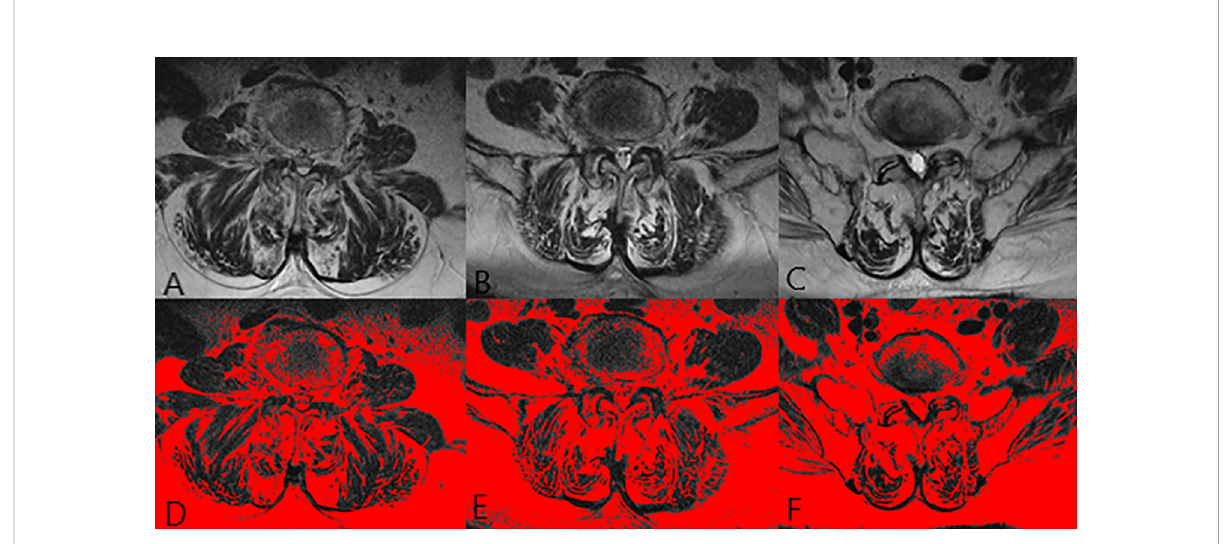
FIGURE 2 The images of paraspinal muscle in a 70 years old female patient. (A, D) were at L3 level. (B, E) were at L4 level. (C, F) were at L5 level. The FI of MF was 57.6% and the FI of ES was